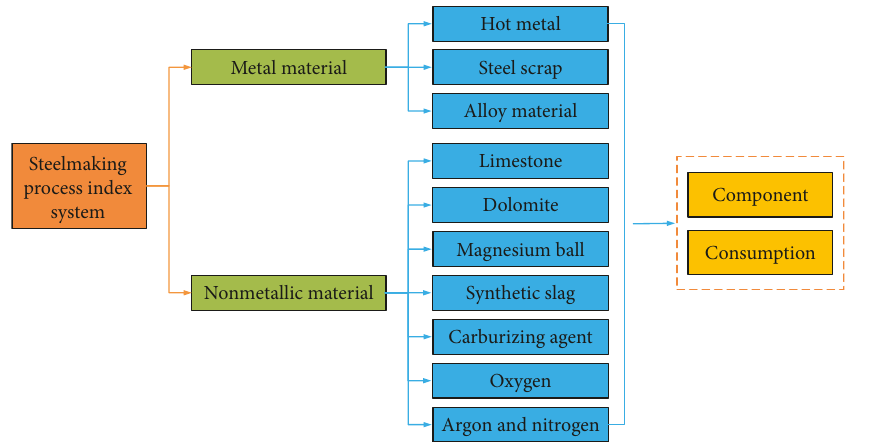
Figure 2: The index system based on steelmaking